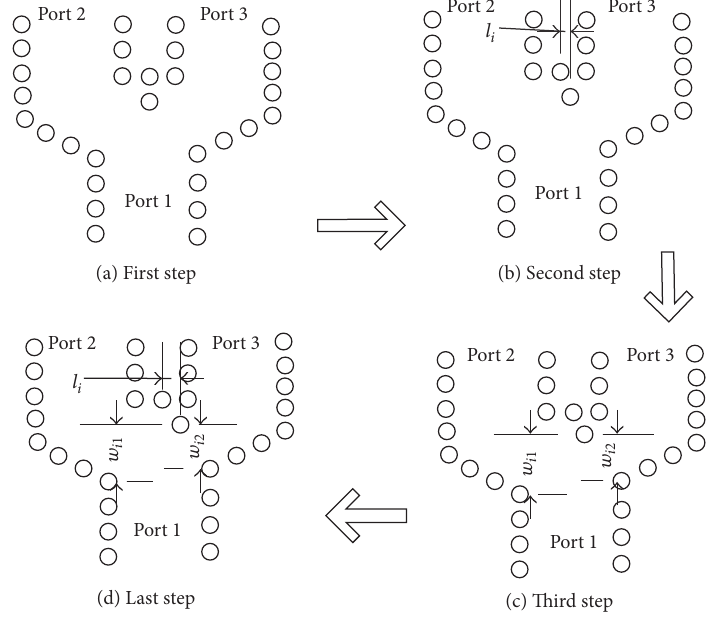
Figure 5: Design process of the proposed unequal divider.